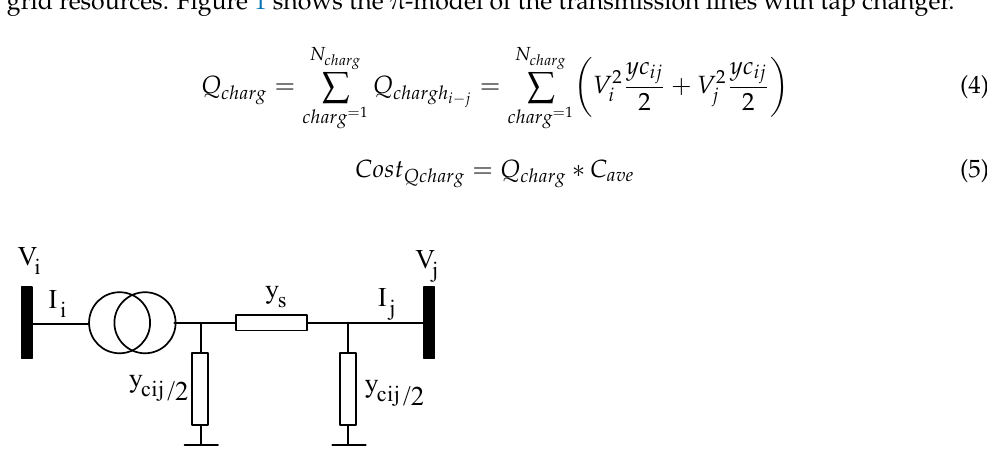
Figure 1. The π -model of the transmission lines with tap changer.